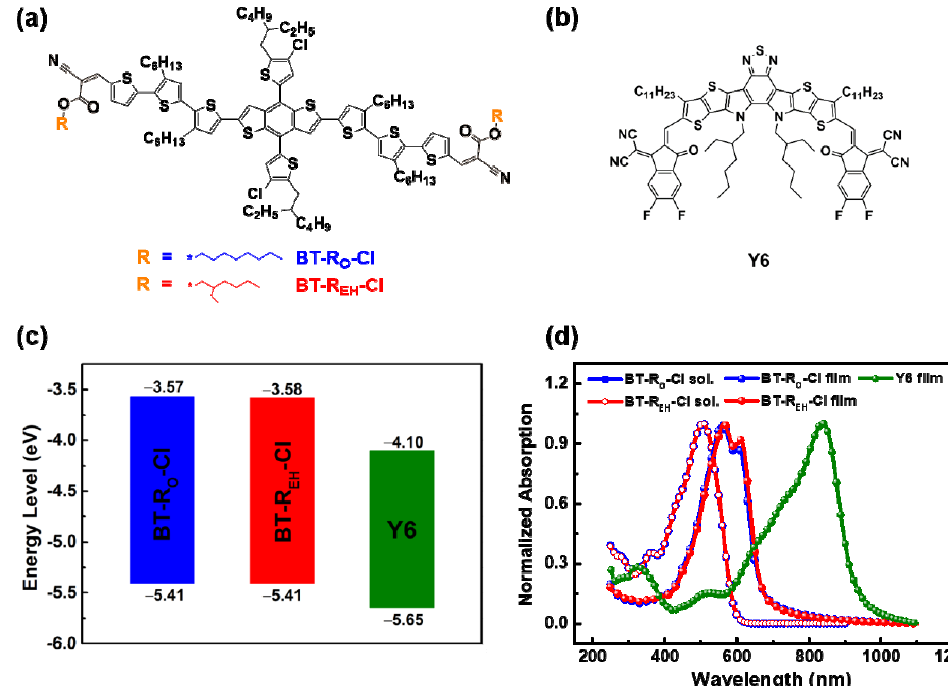
Figure 2. ( a , b ) The molecular structure; ( c ) energy level; and ( d ) solution (in chloroform) and film absorption of BT-R O -Cl, BT-R EH -Cl, and Y6. Table 1. Parameters of the optical, electrochemical, and solubility nature of BT-R O -Cl and BT-R EH -Cl.